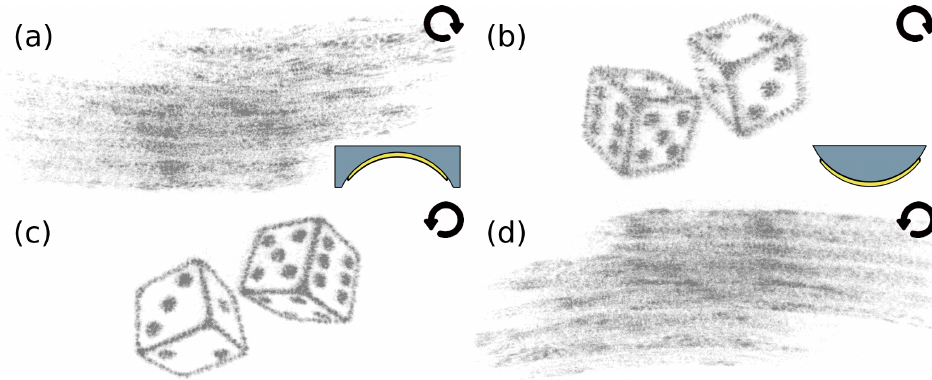
Figure 3. Experimental holographic images where ( a , b ) were illuminated with right-handed (RCP) and ( c , d ) with left-handed circular polarizations (LCP), respectively, with λ = 630 nm. ( a , c ) used a concave substrate with a radius of curvature of 6 mm; ( b , d ) used a convex substrate with the same radius of curvature. The LCP images are rotated 180 degrees in the holographic image plane compared to the RCP images.